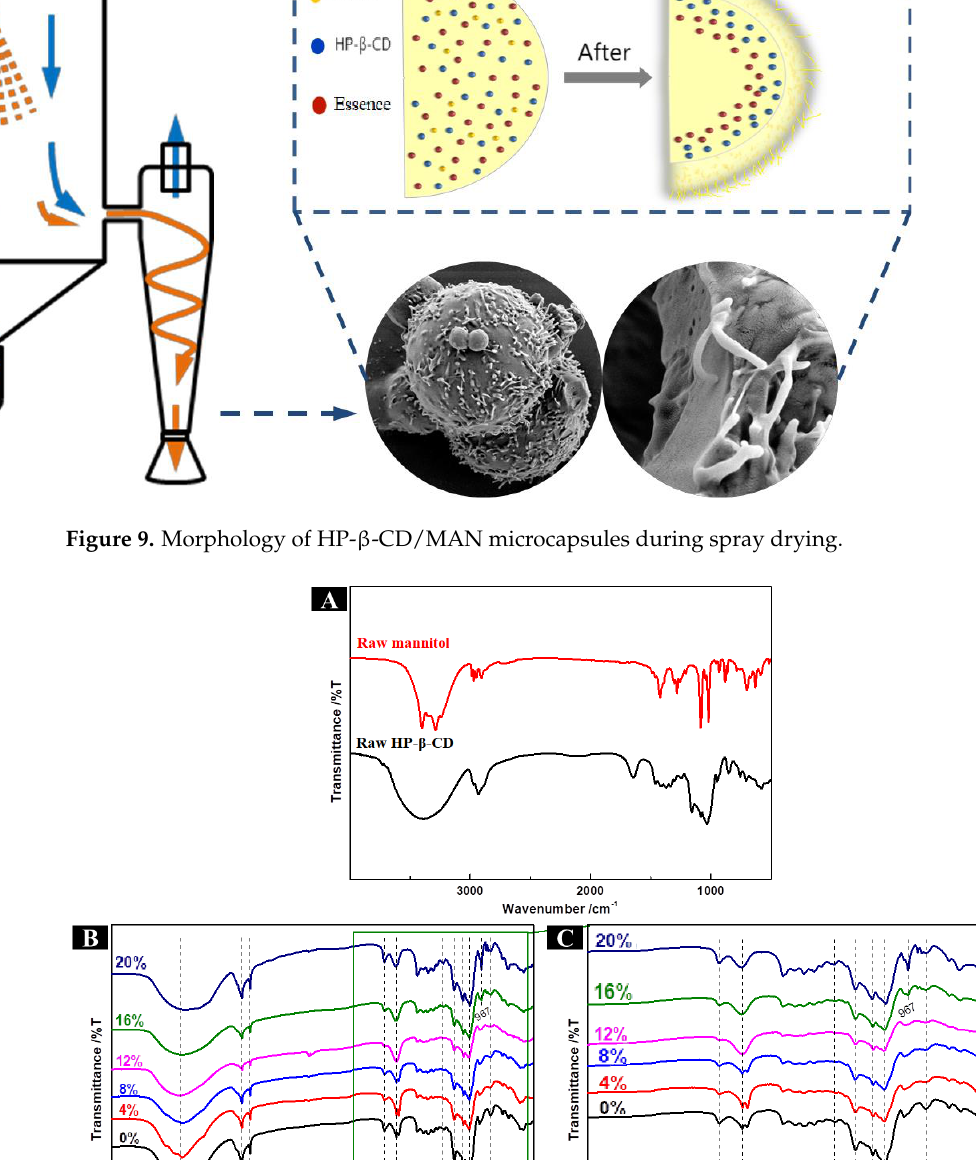
Figure 8. XRD patterns of ( A ) raw materials (HP- β -CD, mannitol, glyceryl monostearate, and sugar